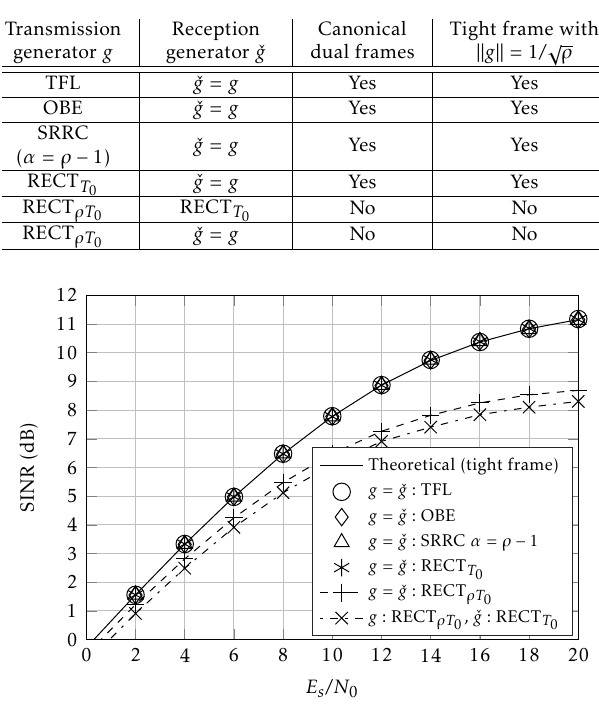
Figure 2. SINR as a functionof E